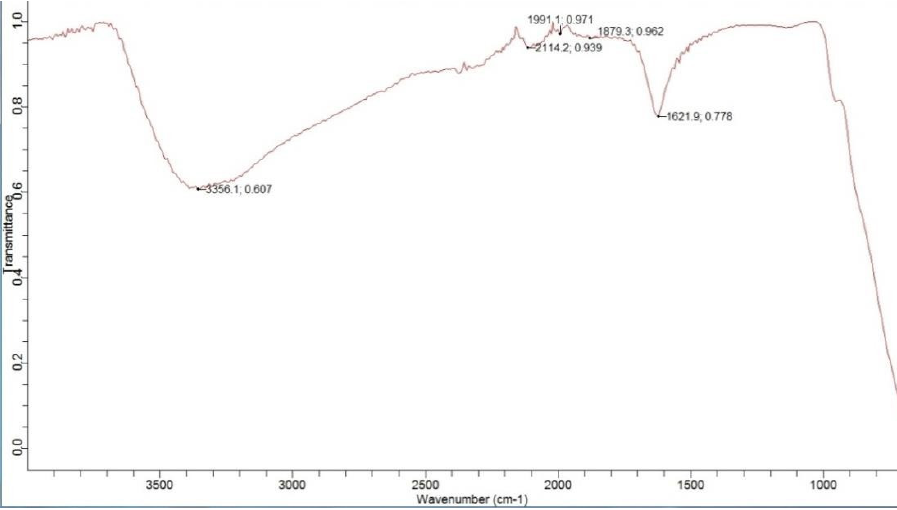
Figure 6. FTIR spectrum of g-C 3 N 4 -SnWO 4.